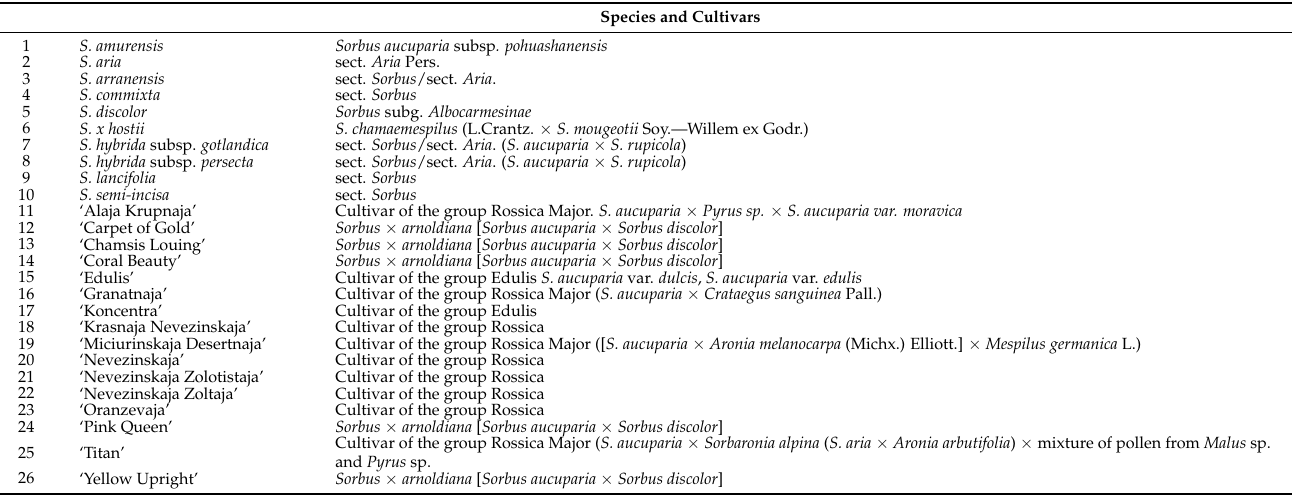
Table 4. Sorbus L. species and